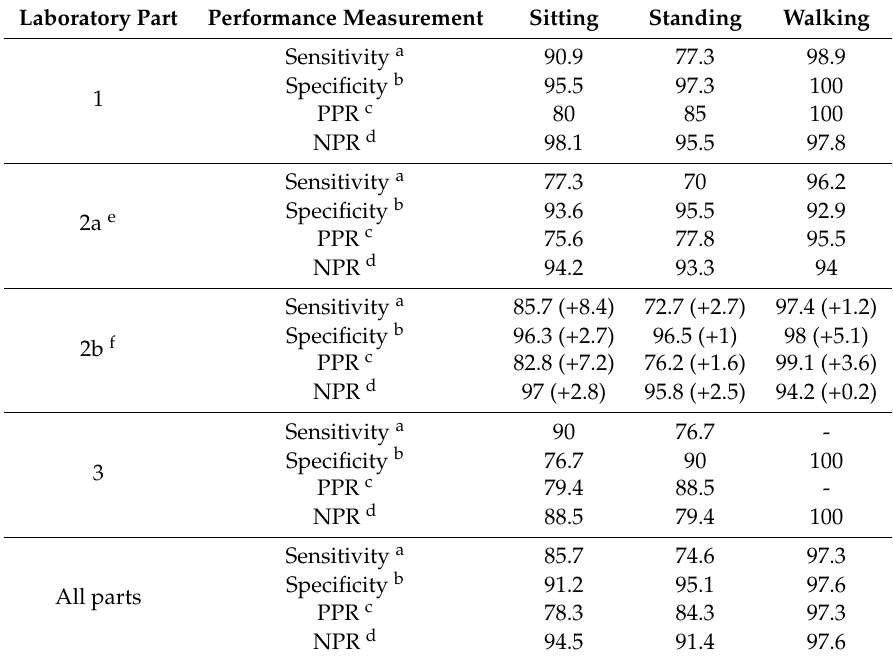
Table 3. Laboratory: performance of the VitaBit with direct observation as criterion measurement. Laboratory Part Performance Measurement